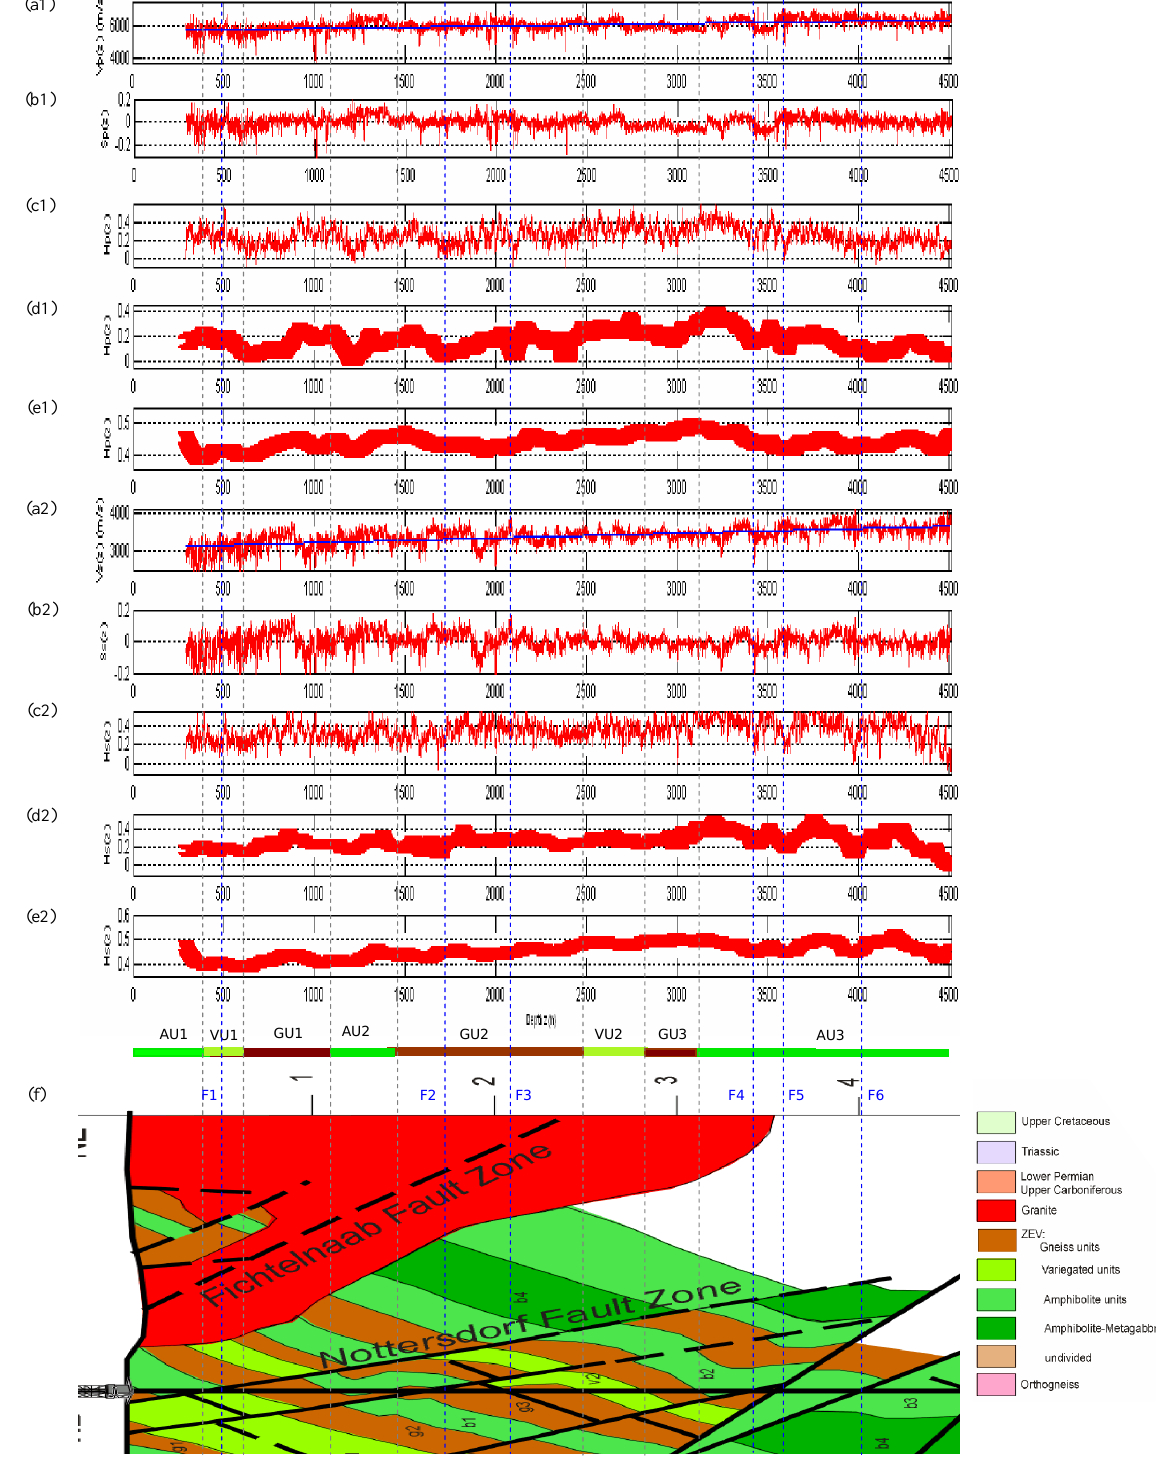
Fig. 4. Results obtained from sonic measurements recorded at the main borehole (HB). The same abbreviations as in Fig. 3. Nonlin. Processes Geophys., 17, 455–466,